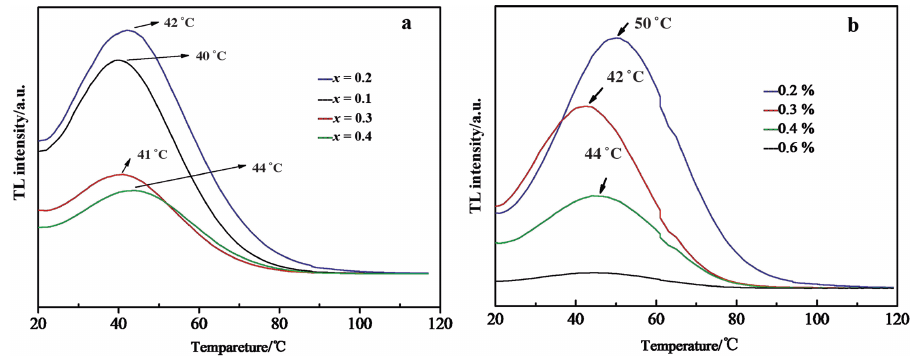
Figure 6: TL curves of samples with different Zn 2 + content (a) and Pr 3 + molar concentration